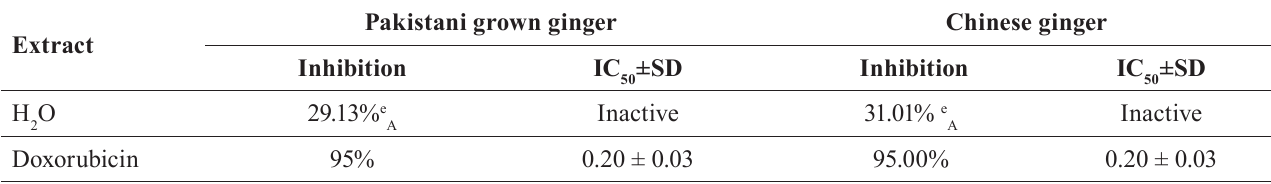
TABLE III - Anticancer activity of extracts from Pakistani grown and Chinese ginger against MCF-7 cell line